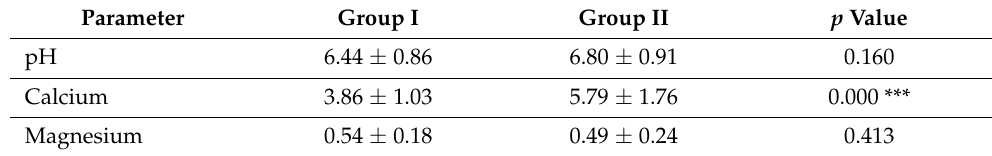
Table 3. Comparative analysis of biochemical parameters among the study group. Table 5. Correlation analysis of parameters in Group II.